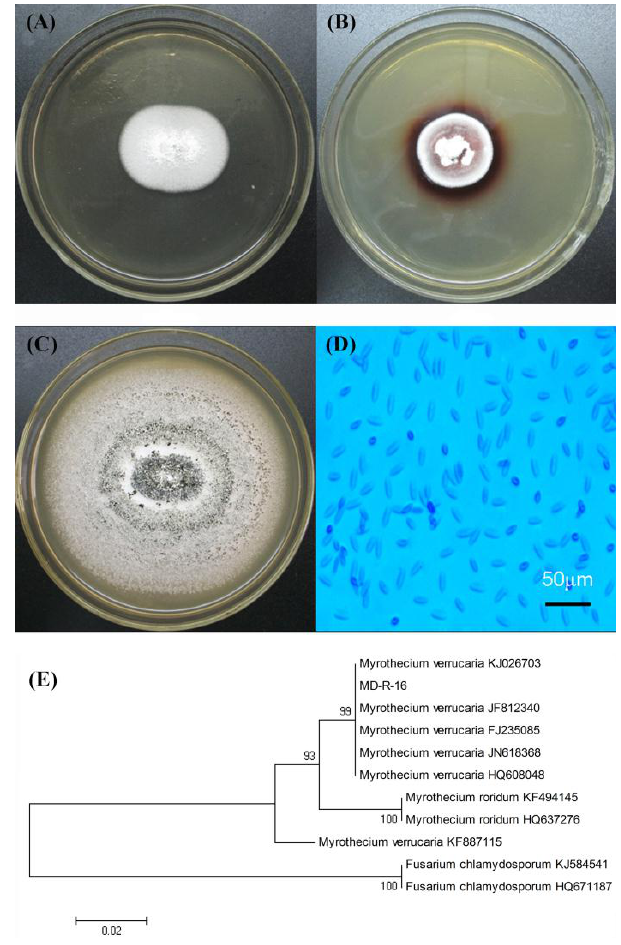
Figure 1. Laccase-producing fungal endophyte isolated from pigeon pea. ( A ) laccase-producing fungal endophyte on the potato dextrose agar (PDA) without guaiacol; ( B ) laccase-producing fungal endophyte on the PDA with laccase indicator-guaiacol; ( C ) and ( D ) represented the fungal endophyte MD-R-16 of colonial morphology and micrographic characteristics ( × 400), respectively; ( E ) phylogenetic tree constructed by the program neighbor-joining (NJ) based on ITS1-5.8S-ITS2 sequences of laccase-producing fungal endophyte. Bootstrap values (1000 tree interactions) are indicated at the nodes.